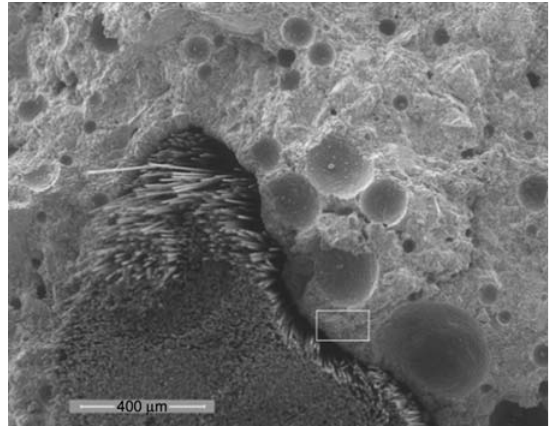
Figure 5 SEM micrograph of the cross section of specimen S5 after the pull-out